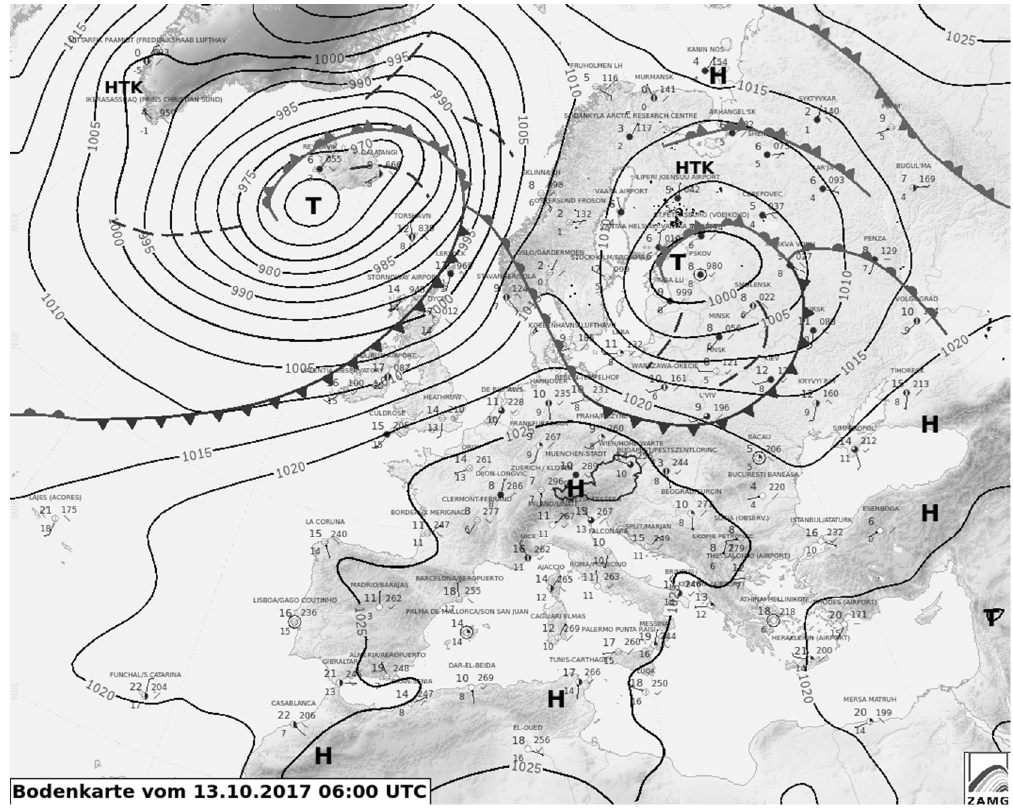
Figure 2. Weather map issued by the Austrian Meteorological Service ZAMG for the 13 October 2017 for 6 UTC [23]. H = high pressure; T = low pressure; HTK = upper-level low.